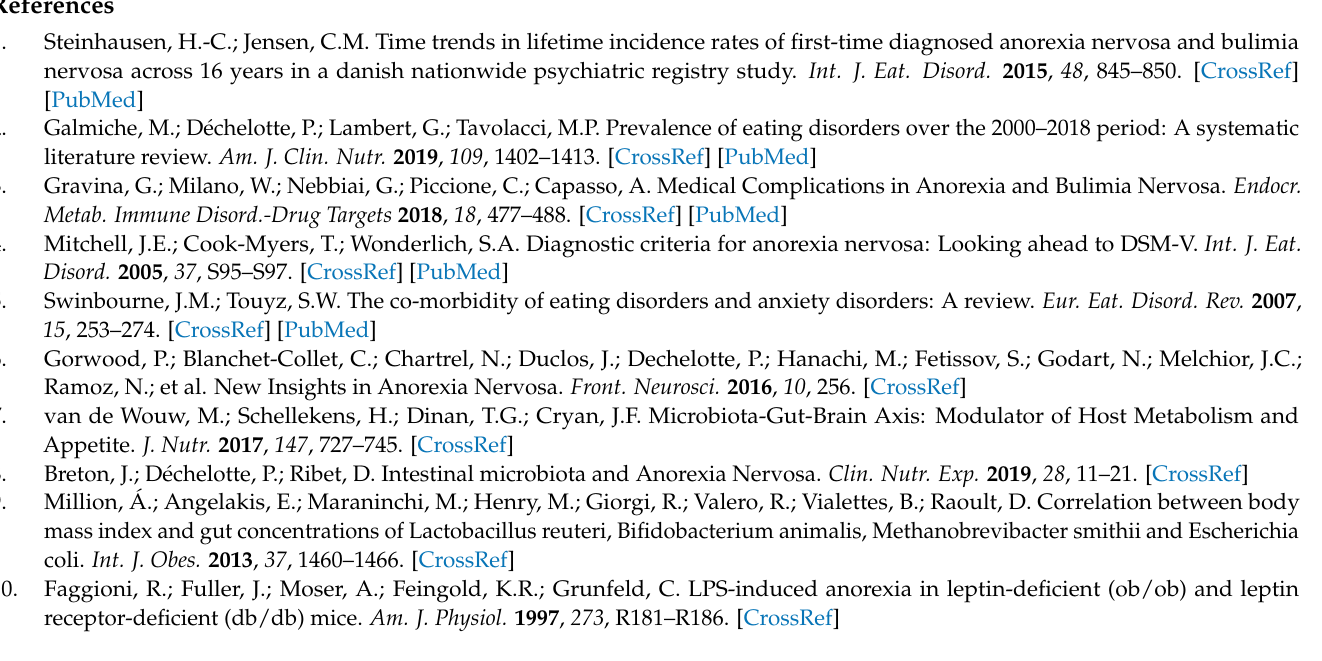
ing PCR; Figure S2: Timeline of experimental protocol; Figure S3: Body composition at day 3 in male and female mice; Figure S4: Open field test at d3 in male and female mice; Figure S5: Total wheel activity in male and female ABA